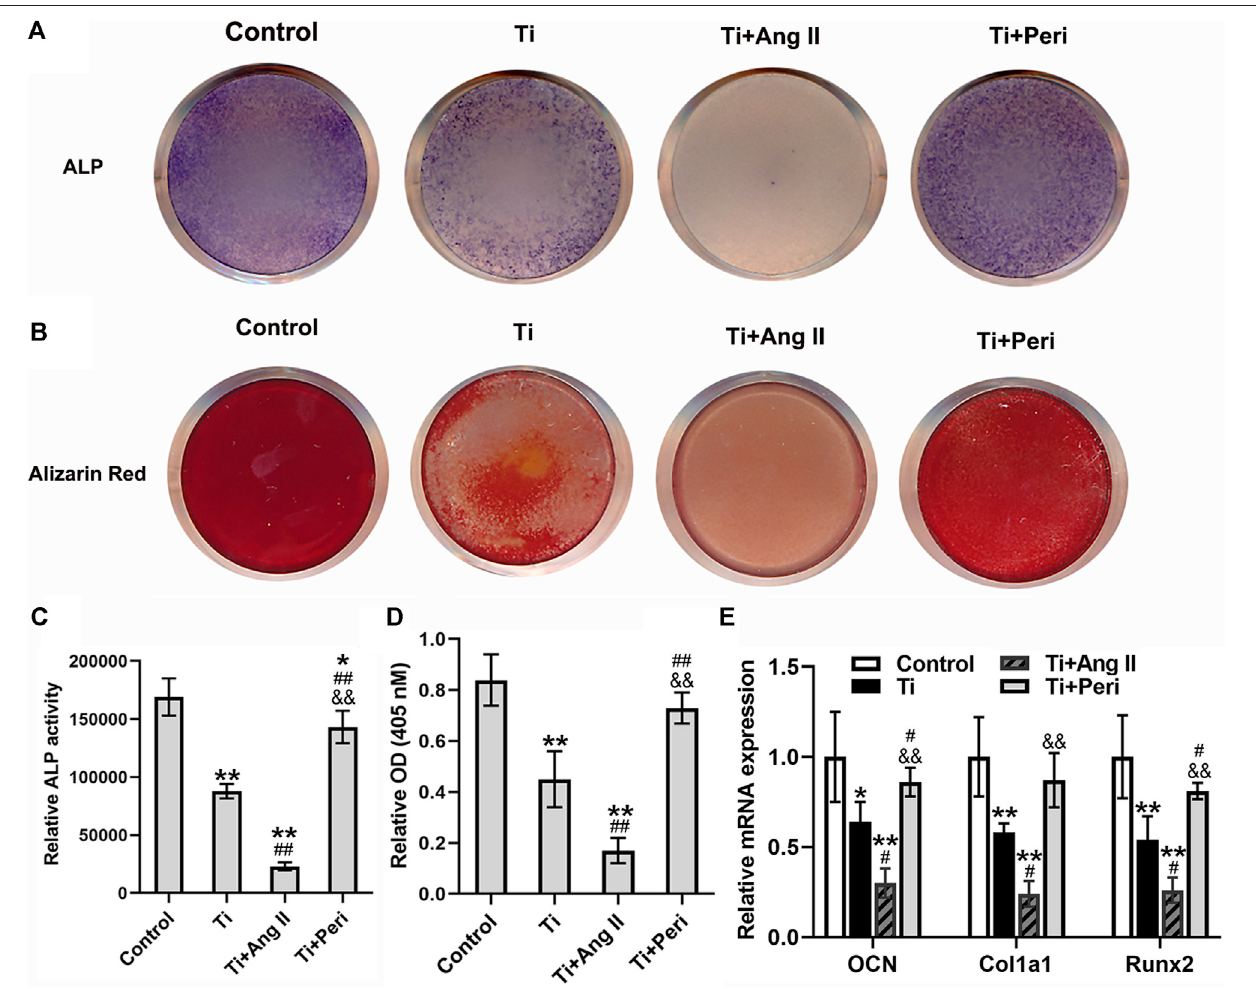
FIGURE 6 | Ang II enhanced but perindopril repressed Ti-particle-induced suppression of osteogenic differentiation in mouse BMSCs. Data are representative images or expressed as the mean ± SD of each group from three separate experiments ( n (cid:1) 3 per group). (A) Representative images of ALP staining on day seven (photo). (B) Representative images of alizarin red staining on day 21 (photo). (C) ALP activity on day seven. (D) Mineralization quantitated from stained mineral deposits. (E) mRNAlevelsofosteogenicgenes(OCN,Col1a1,andRunx2)on fi ve.* p < 0.05vs.thecontrolgroup;** p < 0.01vs.thecontrolgroup;# p < 0.05vs.theTigroup; ## p < 0.01 vs. the Ti group; && p < 0.01 vs. the Ti + Ang II